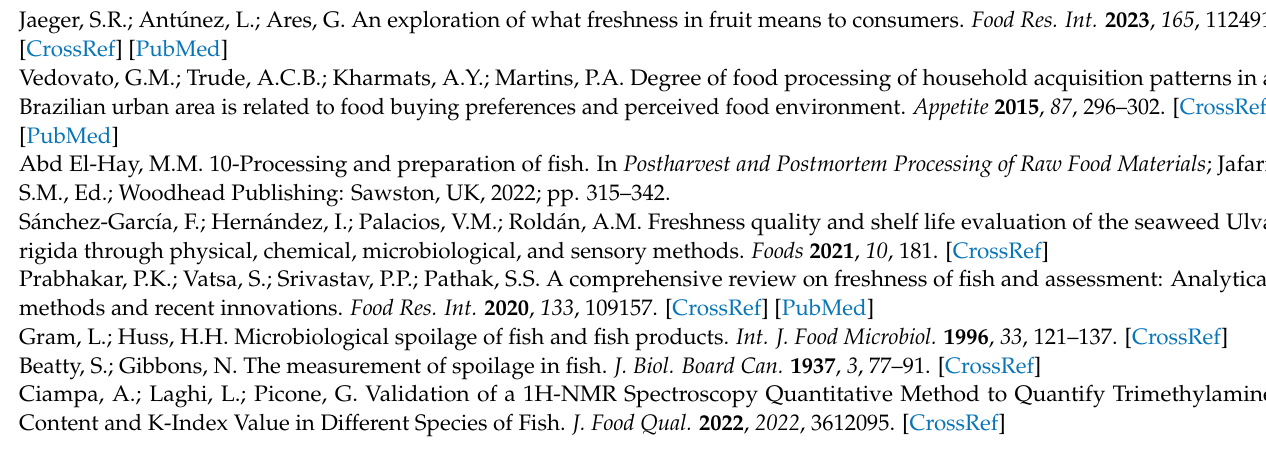
MHz. Table S1: TMA-N concentrations for red mullet (Mullus barbatus) and bogue (Boops boops) samples at T0, T4, T7, T11, and T15. All the concentrations were calculated via NMR by using the protocol fine-tuned by Ciampa et al. [8]. Table S2: K-index values (%) for red mullet ( Mullus barbatus ) and bogue ( Boops boops ) samples at T0, T4, T7, T11, and T15. All the concentrations were calculated via NMR by using the protocol fine-tuned by Ciampa et al. [8]. Table S3: metabolites identified